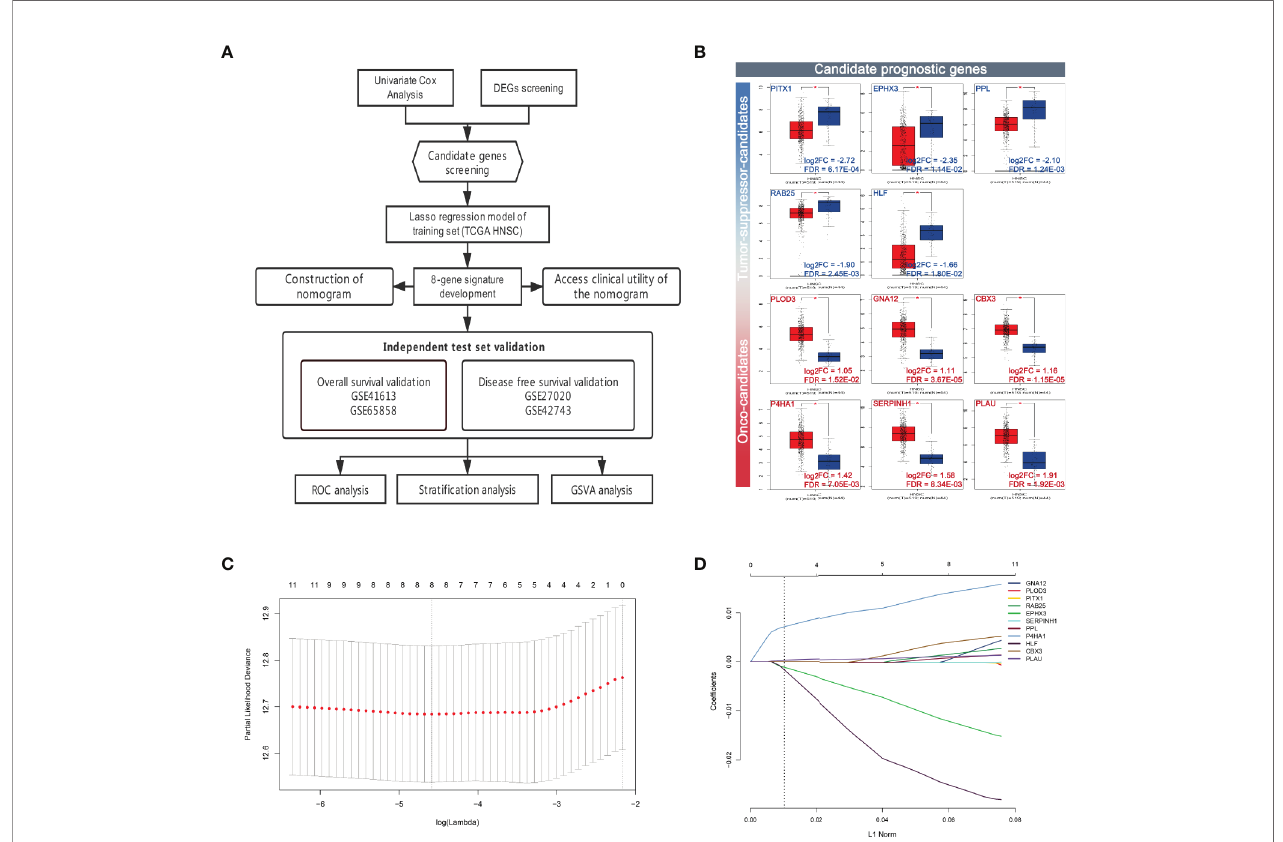
FIGURE 1 | Work fl ow and construction of LASSO Cox regression model. (A) Work fl ow of the study. (B) Expression of the candidate prognostic genes. (C) The LASSO coef fi cients pro fi les of 11 candidate prognostic genes. (D) Tuning parameter ( l ) selection cross-validation error curve. The vertical lines were drawn at the optimal values by the minimum criteria and the 1-SE criteria. We choose the right line by 1-SE criteria where the eight-gene signature was